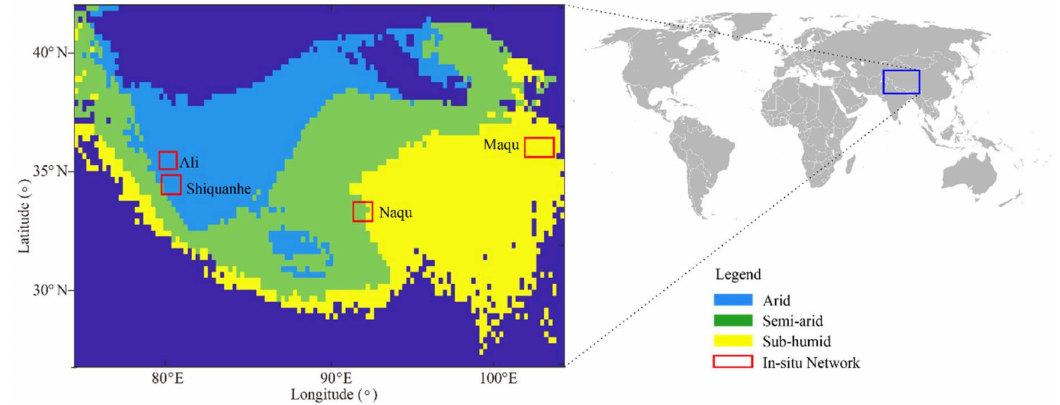
Figure 1. Tibetan Plateau Location in the World Map and In-situ Measurement Networks Distribution over Study